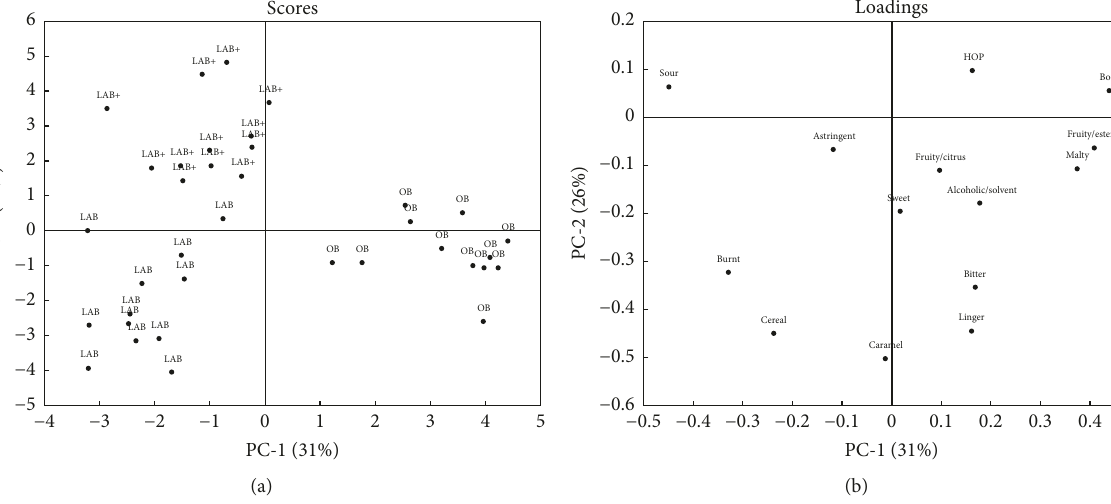
whereas PC2 explains an additional 16% of the variance. The beer samples are variously distributed and LAB+ sample is overlapped with OB in the positive PC1 quadrant, in terms of fruity-esters, fruity-citrus, and alcoholic descriptors. Sweet and fruity-citrus descriptors show an evident correlation with the OB sample, while burnt and hop are more related to the LAB